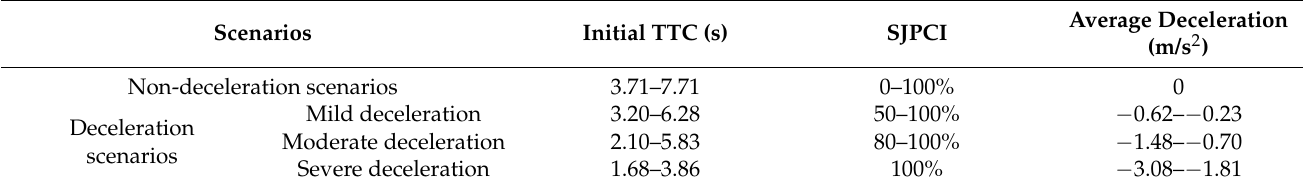
Table 1. Data statistics of different